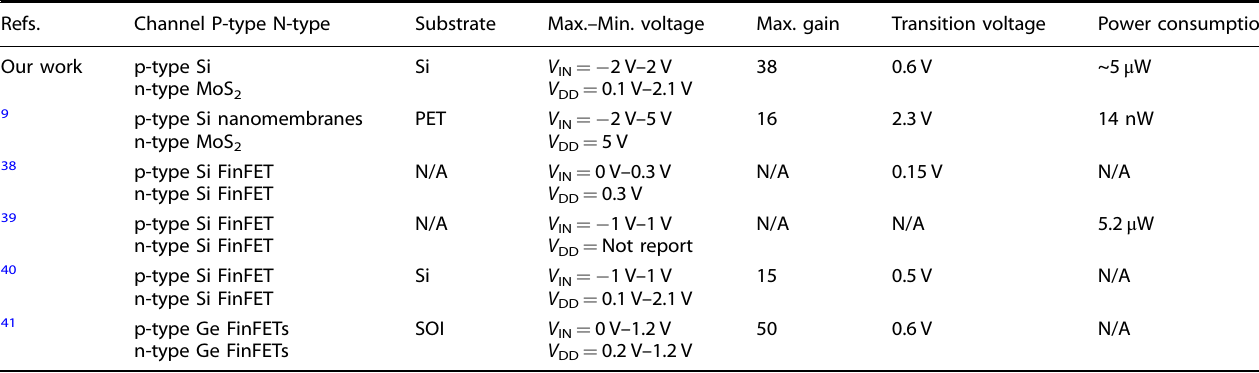
Table 2. Comparison of the inverter performance in this work and other researchers ’ works.